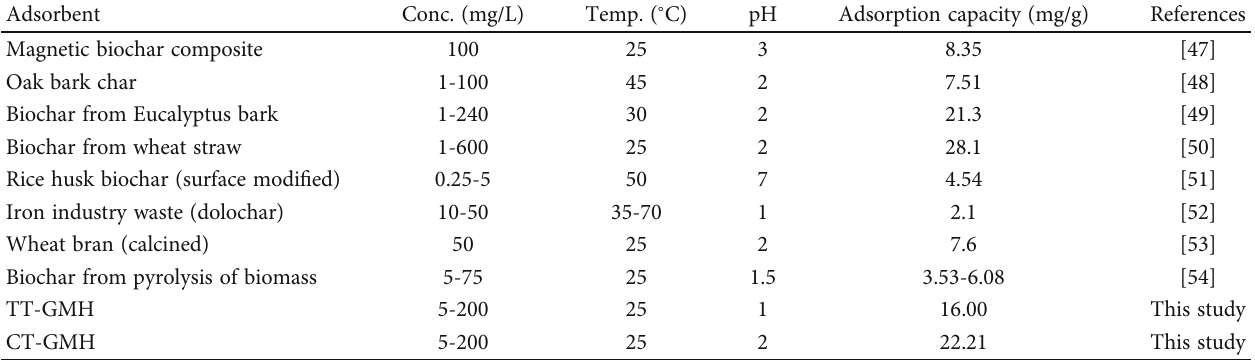
Table 6: Comparison of adsorption capacities of di ff erent adsorbents for the removal of Cr(VI).